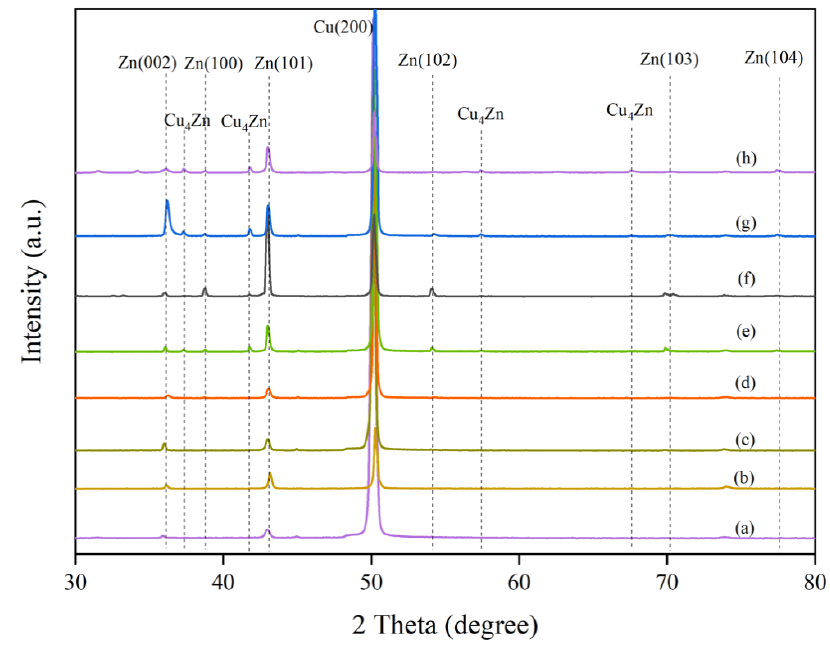
Figure 3. XRD patterns of (a) Zn/Cu–Na60, (b) Zn/Cu–Na200, (c) ZnCu/Cu–Na60, (d) ZnCu/Cu–Na200, (e) Zn/Cu–H60,